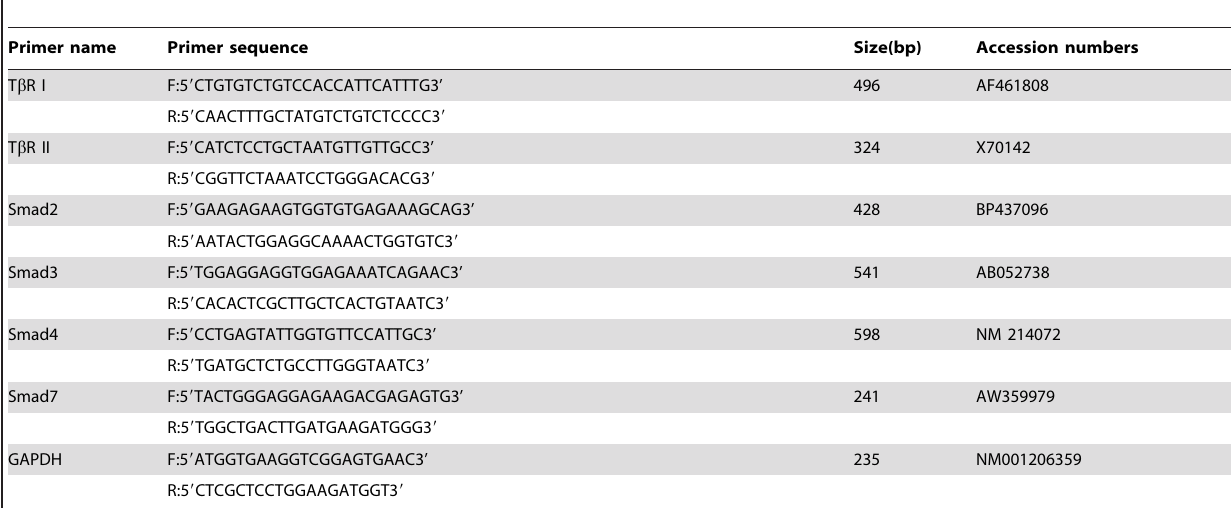
Table 1. Genbank accession numbers, sequences of forward and reverse primers, and fragment sizes used for real-time PCR.